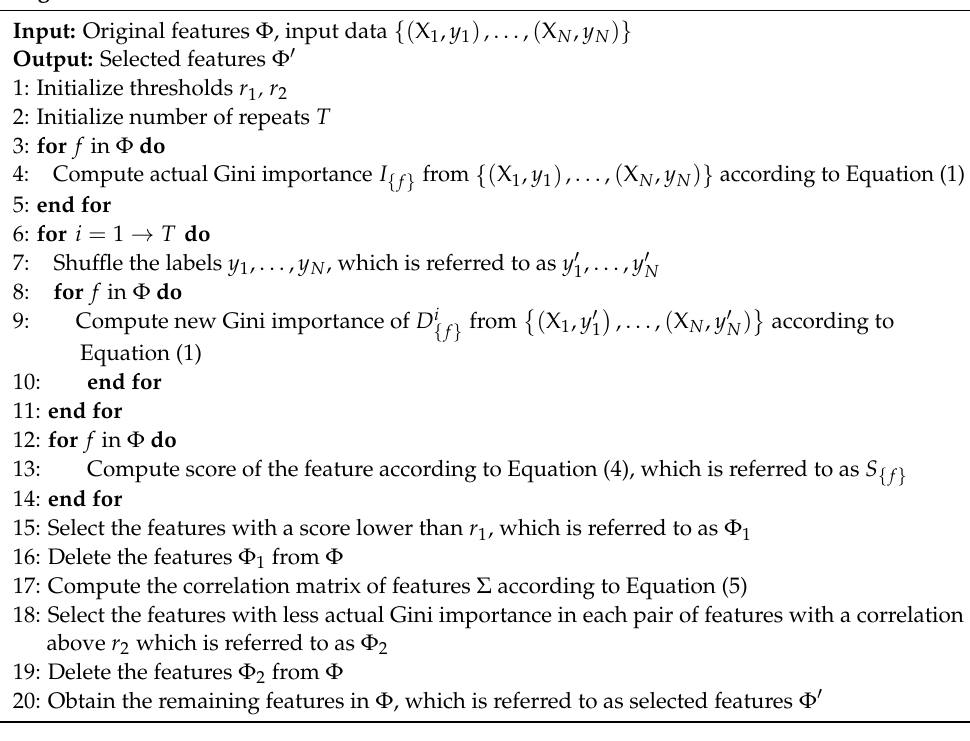
Algorithm 1 Feature